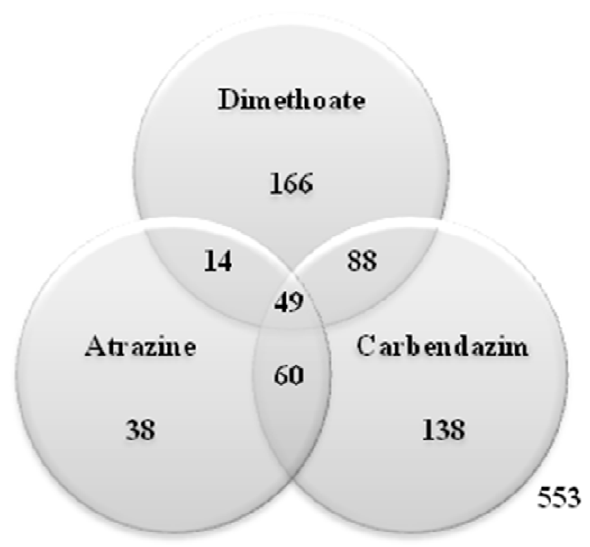
Figure 3. Venn diagram representing the number of differen- tially expressed genes shared by the three pesticides.